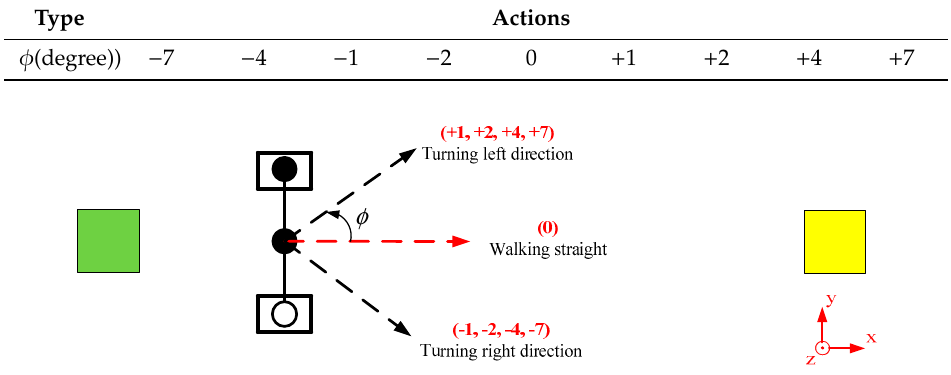
Figure 18. Turning direction with nine actions.